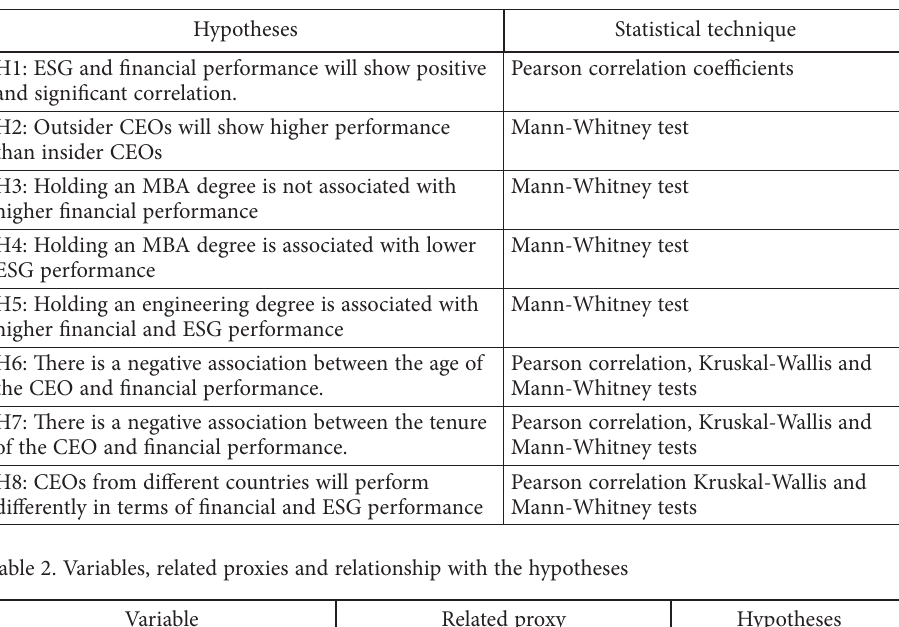
Table 1. Summary of the hypotheses and statistical analysis